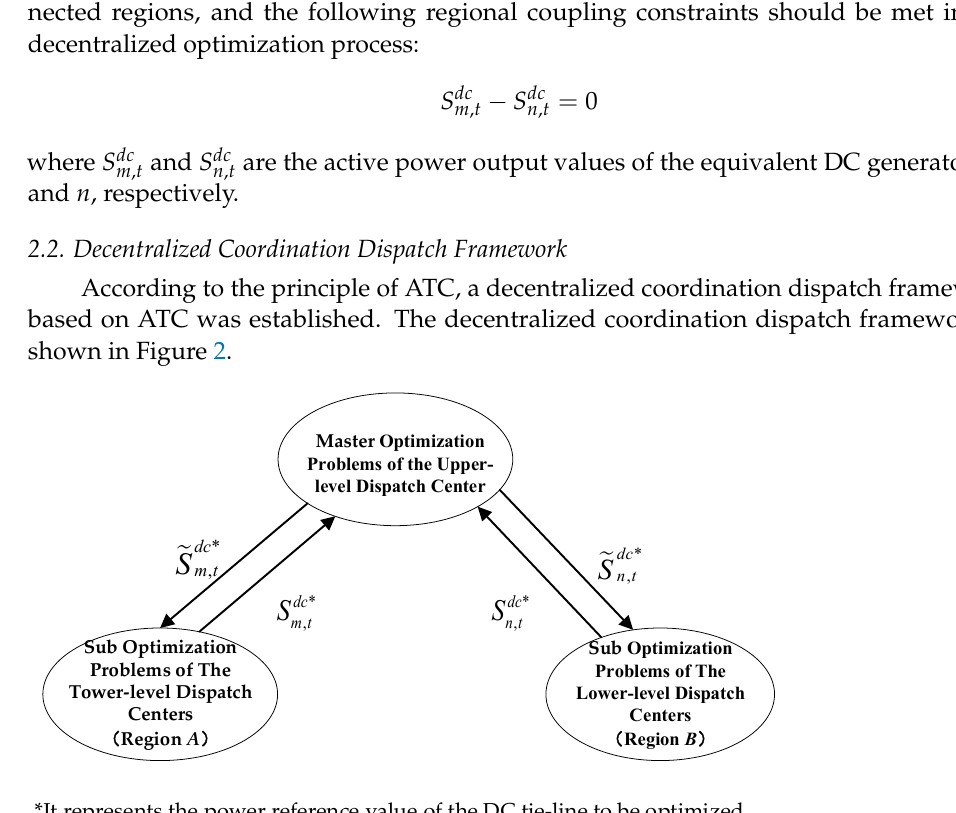
Figure 2. Decentralized coordination dispatch framework.